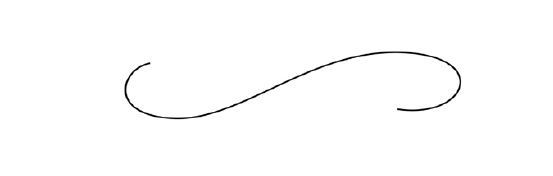
Figure 3. A moving dot generates an active line. The movement is circular. Drawings inspired by the Klee’s original (1965).